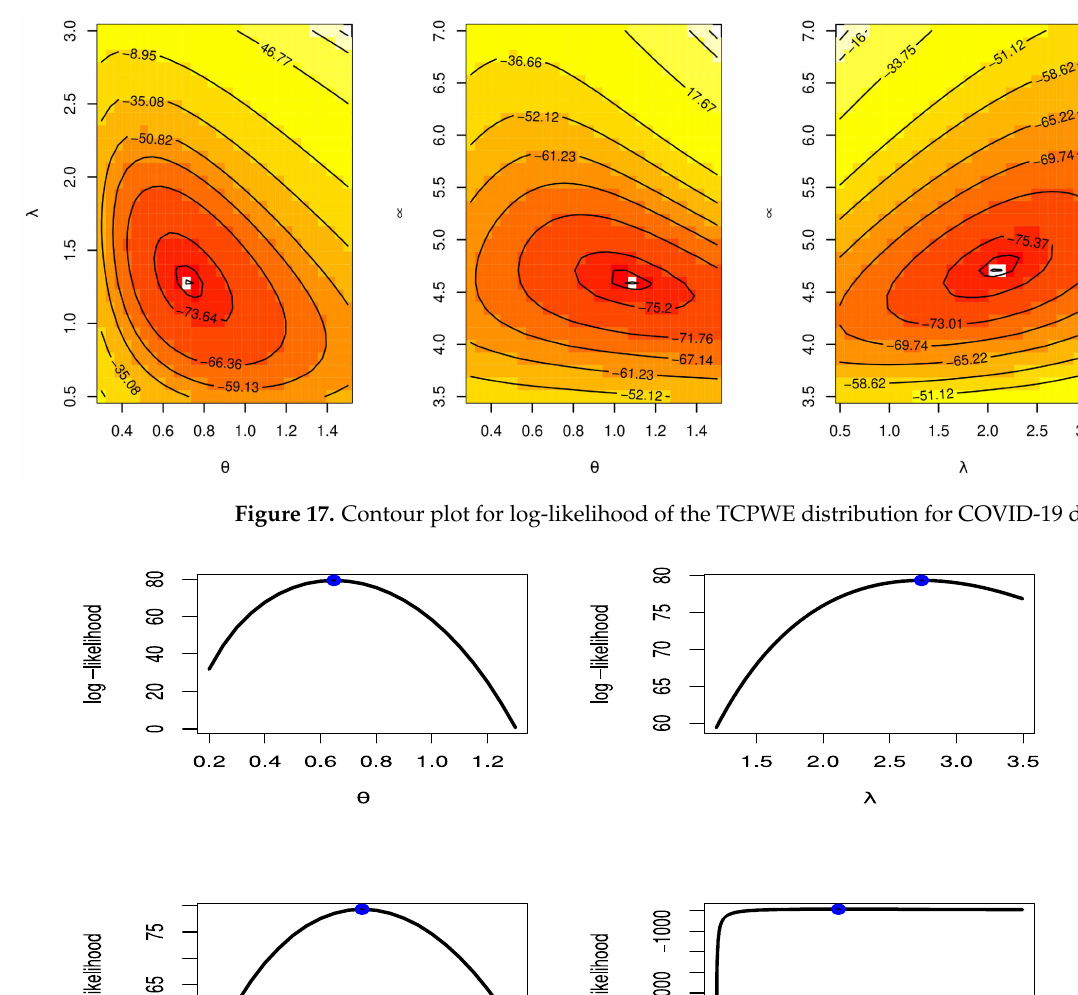
Figure 16. Contour plot for log-likelihood of the TCPWE distribution for fatigue times